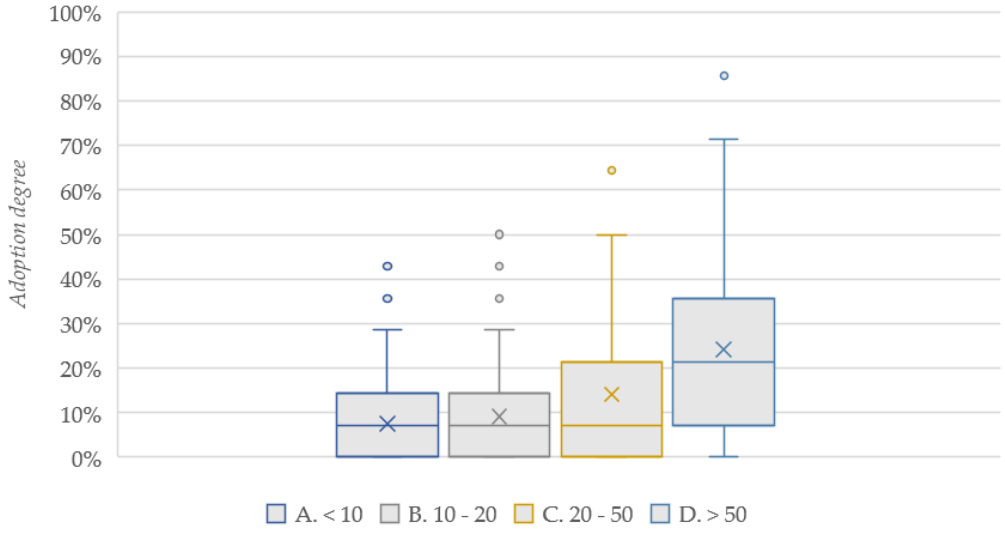
Figure 8. Boxplot graph of the utilization rate depending on company size (land size).